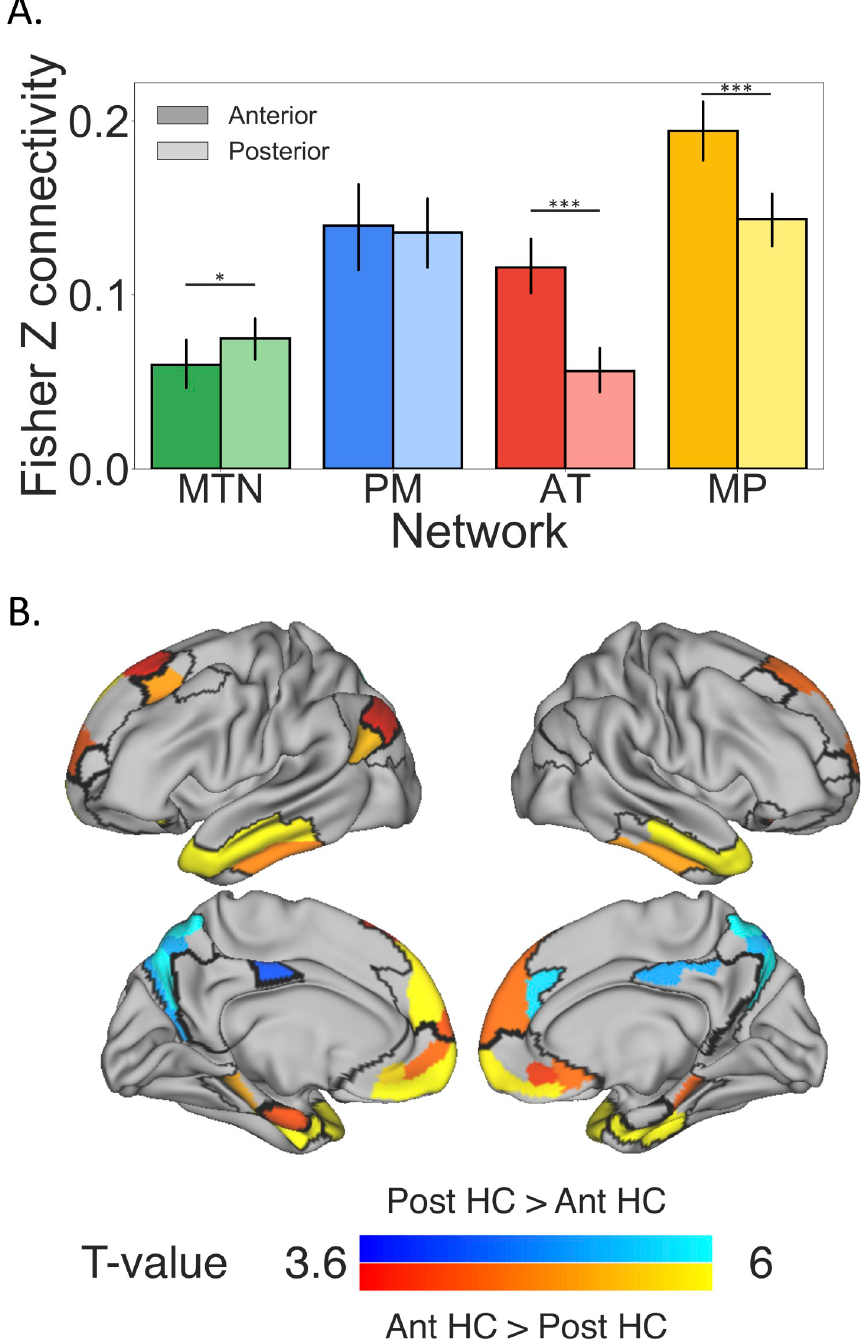
Fig 5. Regions within the MTN and DMN subnetworks exhibit differential FC with the anterior and posterior hippocampus. (A) Bar graphs of FC from each of the cortical networks to the anterior and posterior hippocampus. Error bars show 95% confidence interval. (B) T-contrast of anterior hippocampal connectivity versus posterior hippocampal connectivity, with warm colors showing regions that had stronger anterior hippocampal connectivity and cool colors showing regions that had stronger posterior hippocampal connectivity. Cortico-hippocampal network boundaries are outlined on the surface of the brain. These results indicate that the temporopolar and mPFC show preferential connectivity with the anterior hippocampus, whereas PM parietal cortex shows preferential connectivity with the posterior hippocampus. Ant, anterior; AT, anterior temporal; DMN, default mode network; FC, functional connectivity; HC, hippocampus; MP, medial prefrontal; mPFC, medial prefrontal cortex; MTN, medial